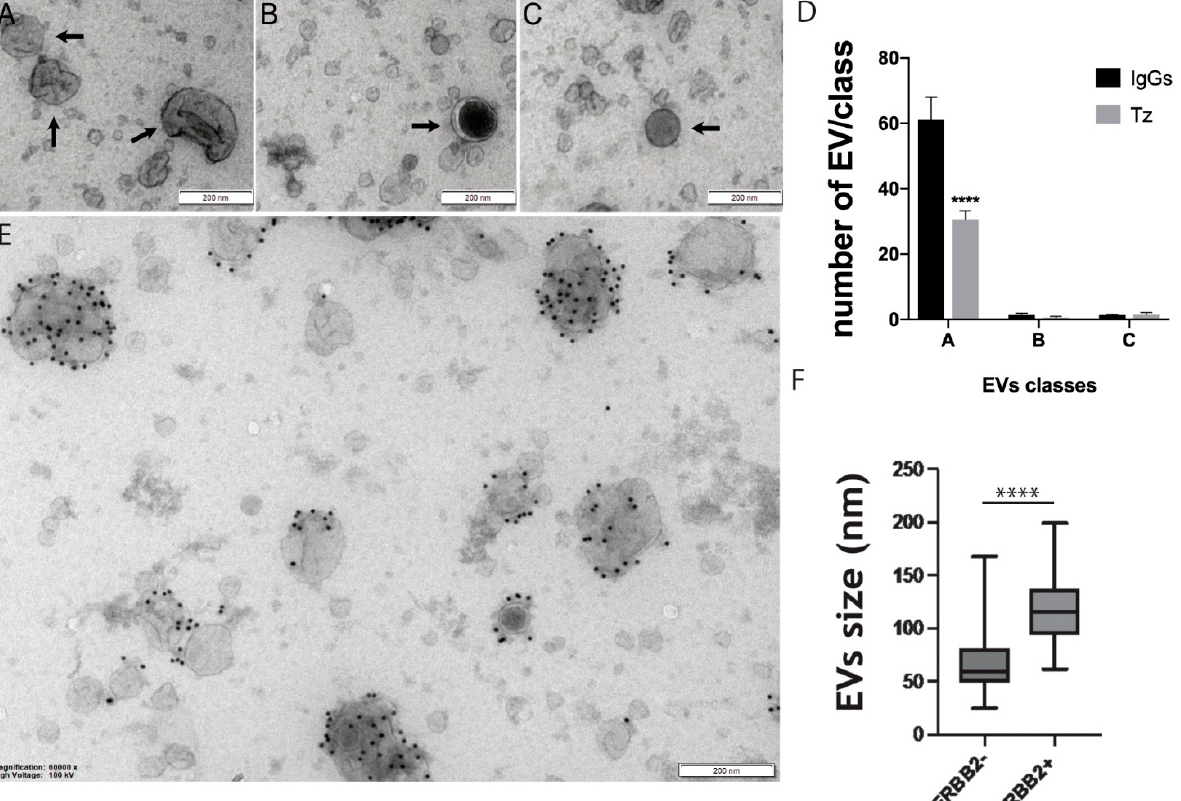
Figure 1. Representative transmission electron microscopy (TEM) images of extracellular vesicles (EVs) purified from conditioned media of SKBR-3 cells. Three classes of EVs, which differ by size and ultrastructure can be identified: ( A ) included 30–300 nm cup-shaped EVs indicated by arrows; ( B ) the 30–200 nm round EVs with a dark electron-dense core and a clear peripheral region indicated by an arrow; ( C ) the 30–80 nm round and homogeneously light electro-dense EVs indicated by an arrow. ( D ) Grouped histogram showing the number of EVs falling into each class in trastuzumab (Tz)-treated compared to immunoglobulins G (IgGs) treated SKBR3 cells and counted on 10 random micrographs at 30,000 × magnification. Bars represent the mean ± SEM. **** p < 0.0001 (2-way ANOVA test). ( E ) ERBB2 specific immunogold staining of purified EVs. ERBB2 was labeled with anti-ERBB2 antibody (9G6, sc-08, Santa Cruz) and protein A gold conjugated (10 nm colloidal gold) was used to reveal the primary antibody. ( F ) Box-and-whiskers boxplot showing size distribution ERBB2 + and ERBB2 − EVs purified from SKBR-3 cells, **** p < 0.0001 (Student’s t-test). Magnification bars = 200 nm.